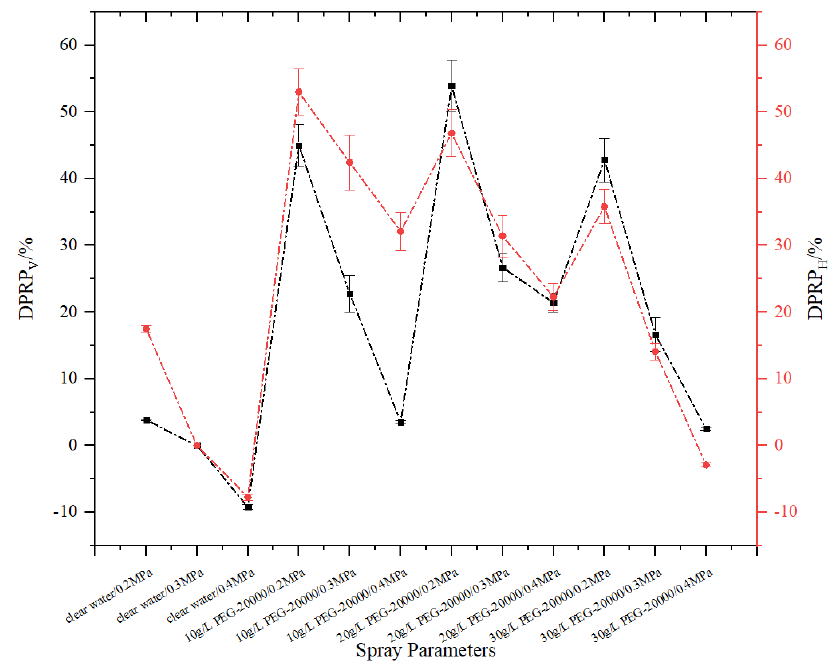
Figure 6. Drift potential reduction percentage under different spray conditions.